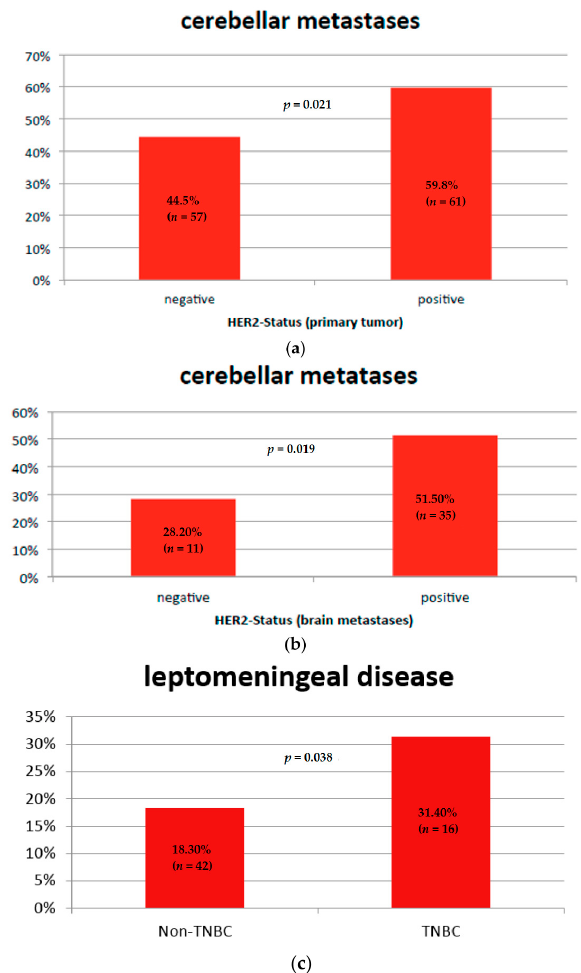
Figure 1. Association between BM patterns and subtypes: ( a ) HER2-status of the primary breast tumor and cerebellar metastases; ( b ) HER2-status (brain metastases) and cerebellar metastases; ( c ) Triple-negative BC and leptomeningeal disease.